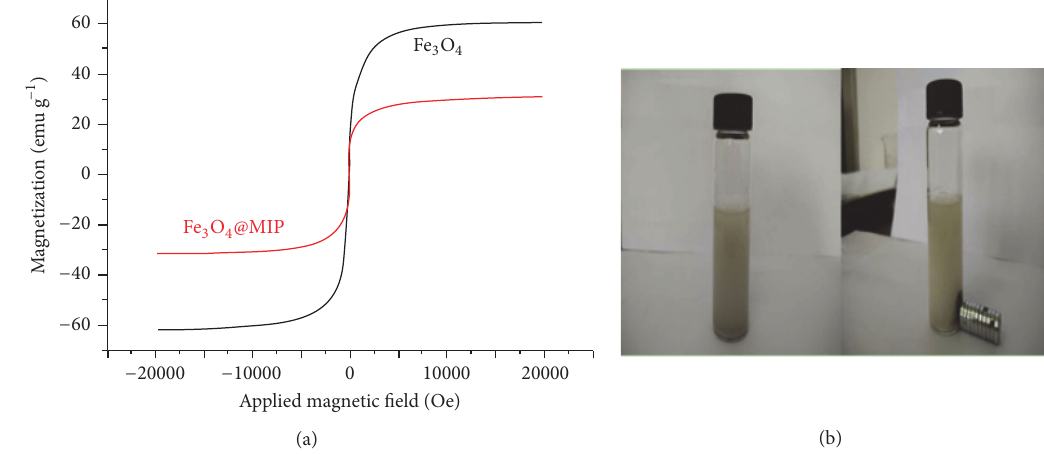
Figure 5: Hysteresis chart of magnetic particles (a) and reaction to external magnetic fields (b).